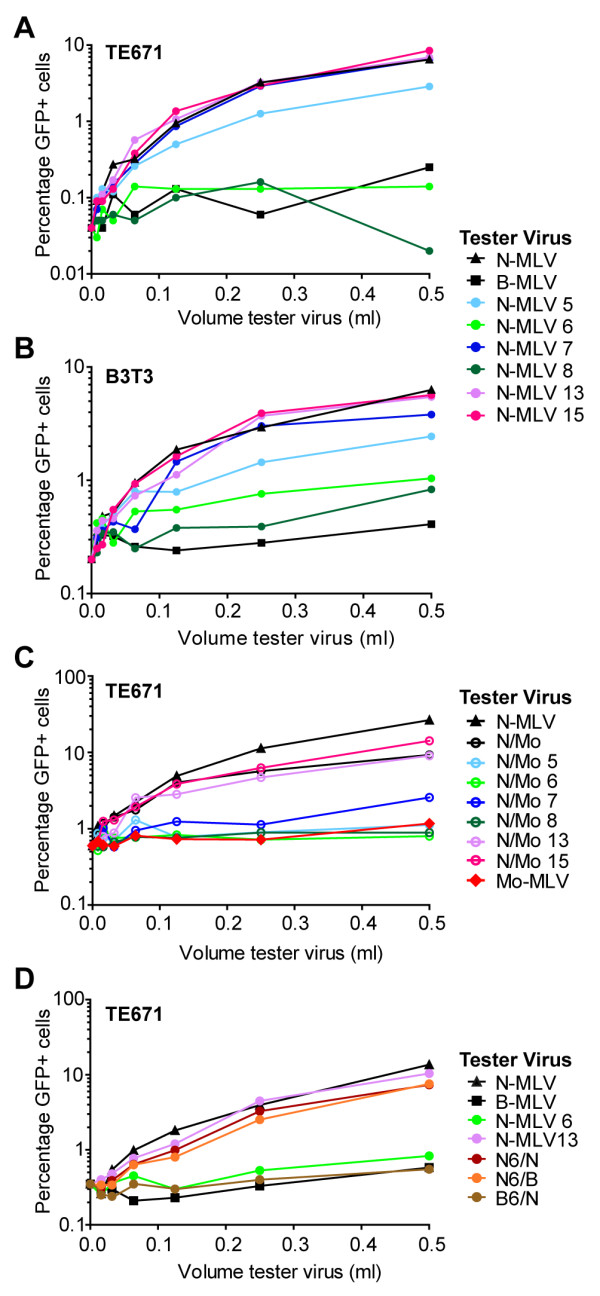
The ability of p12 mutants to saturate TRIM5alpha and Fv1 activity. (A and B) Supernatants from 293T cells containing LacZ-encoding N-tropic MLV (N-MLV) tester viruses, with or without p12 mutations, or B-MLV were serially diluted 2-fold and used to challenge TE671 cells, which express TRIM5alpha (A), or B3T3 cells, that express Fv1b (B). After 4 to 6 hours, the cells were infected a second time with a fixed dose of GFP-encoding N-MLV reporter virus. The percentage of GFP positive cells is plotted for each volume of tester virus. (C) Mo-MLV p12 mutants were converted to N-tropic viruses by changing 3 residues in CA. These mutants (named N/Mo) were used as tester viruses in TE671 cells as described in (A). (D) Mixed particles that contained a mixture of N- or B-tropic CA in addition to mutated and wild type p12 were synthesized as follows: 90% N-MLV mutant 6 with 10% wild type B-MLV (N6/B, orange line), 90% B-MLV mutant 6 with 10% wild type N-MLV (B6/N, brown line) and 90% N-MLV mutant 6 with 10% wild type N-MLV (N6/N, dark red line). These viruses were used to test abrogation of TRIM5alpha restriction in TE671 cells as described in (A). All graphs are representative of at least three independent experiments.